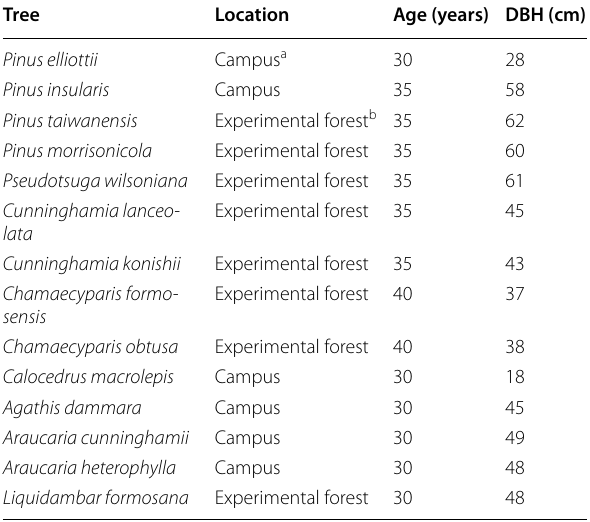
Table 1 The information of exudate‑sampling trees in this